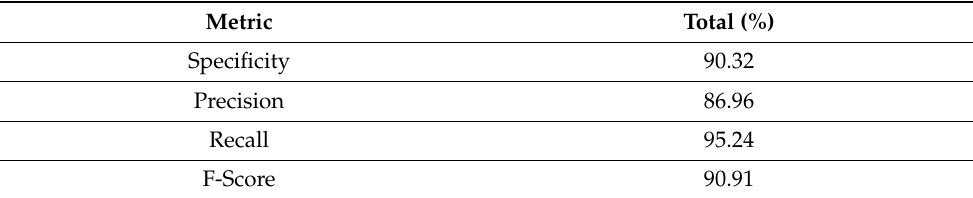
Table 6. Recall and precision for classification of sample SMs for validation.